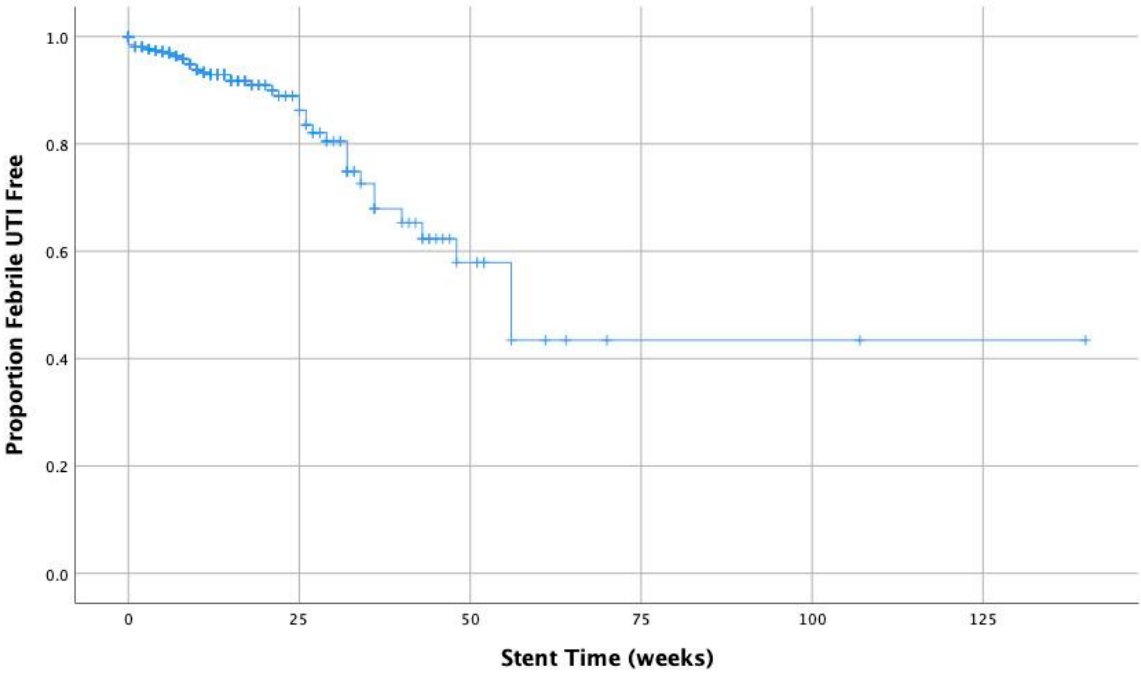
Figure 2. Kaplan–Meier curve for stent dwell time and proportion post-operative febrile UTI free.